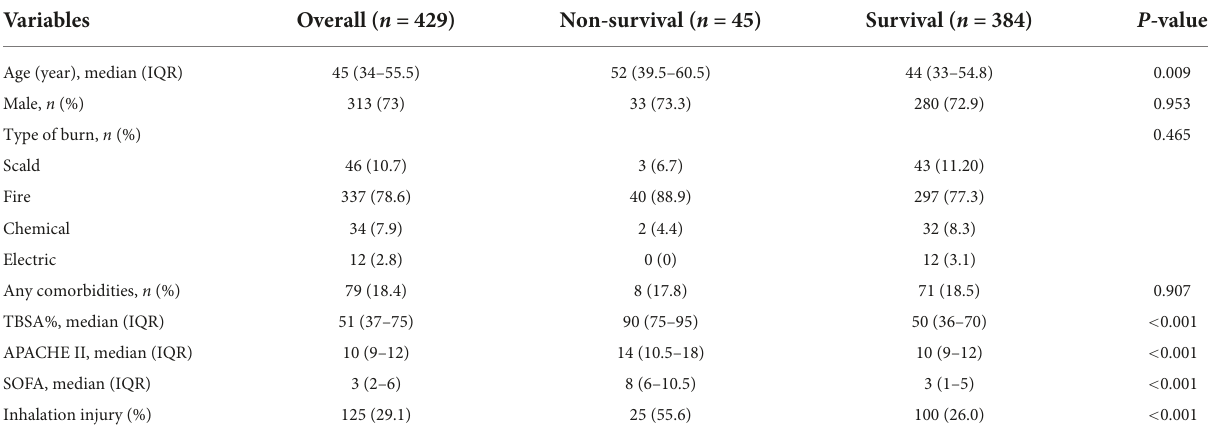
TABLE 1 Demographic information and clinical data ( N =